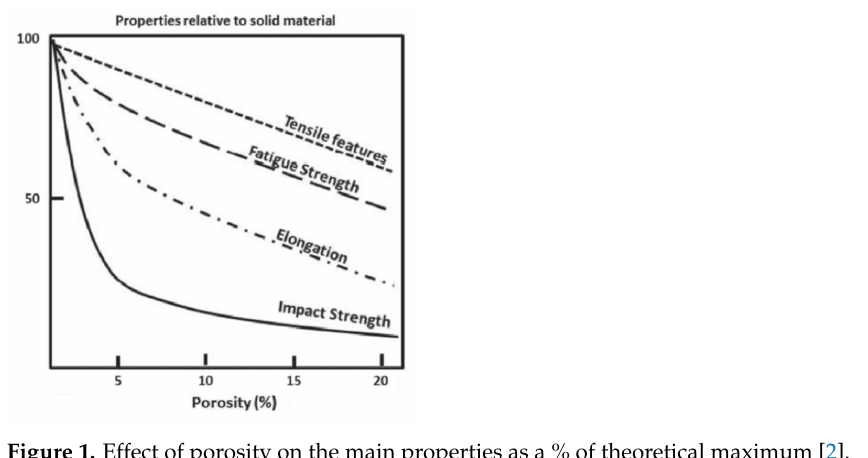
Figure 1. Effect of porosity on the main properties as a % of theoretical maximum